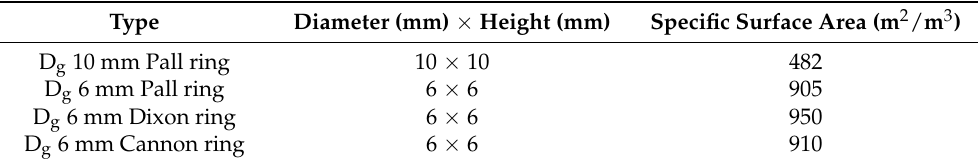
Table 2. Packing parameters.